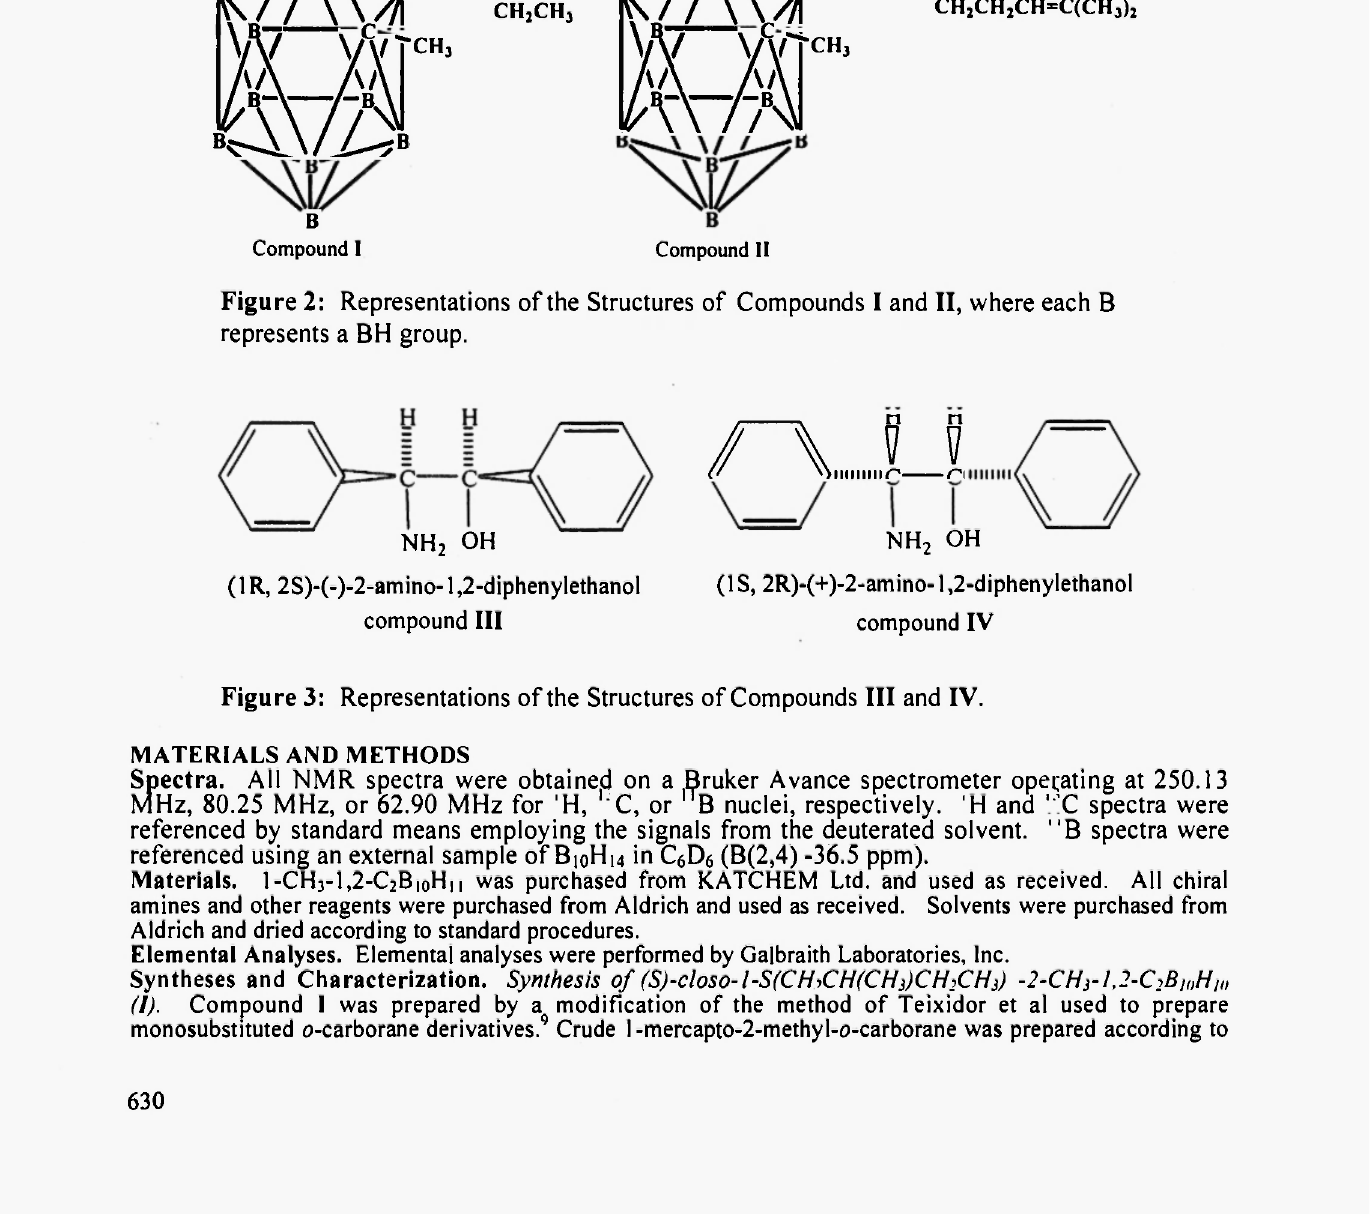
Figure 1: Representation of the [nido-7-R'-8-R 2 -7,8-C 2 B9Hio]' Enantiomers, where each Β represents a Β Η group.